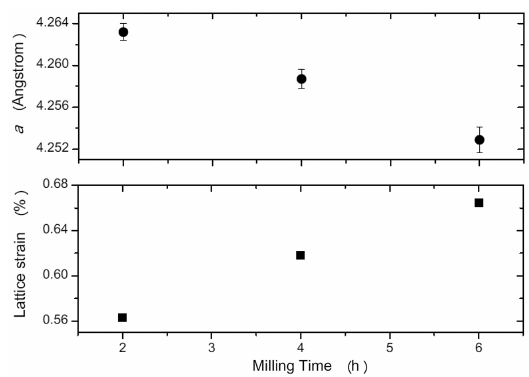
Te mixture 2 4 Te structure by 2 4 were 2 Figure 2. Variation of a lattice parameter and lattice strain of the obtained powders vs. milling